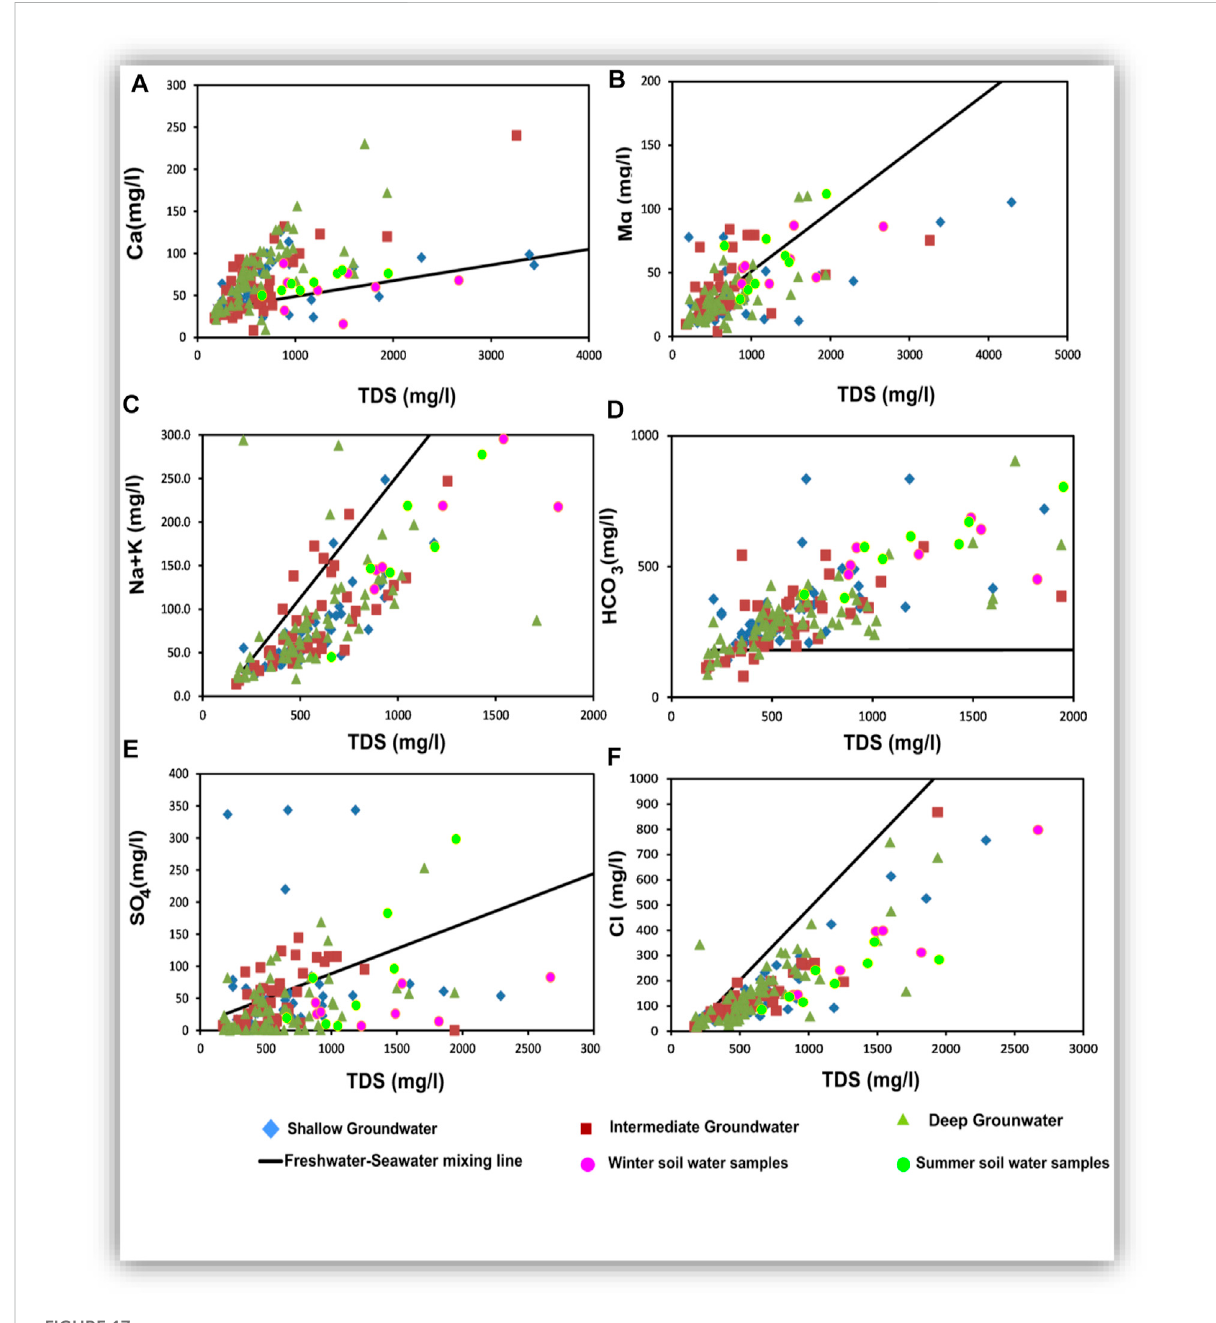
FIGURE 17 The relationships between total dissolved solids (TDS) and ion